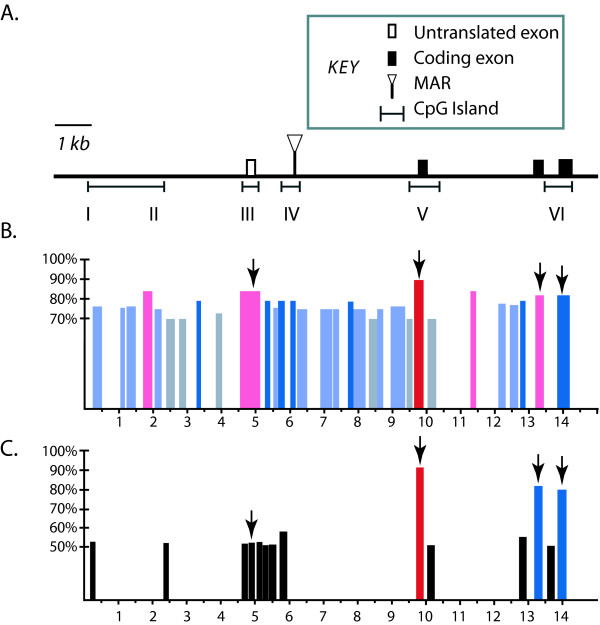
Characterization of the transcription unit for IGF2 in Monodelphis domestica. A) Genomic map of the M. domestica IGF2 gene. The scale bar is indicated and the key to the annotation, which includes coding exons, the 5' noncoding exon, the MAR predicted by MAR-Wiz and CpG islands predicted by CpG Plot, is shown below. B) & C) Evolutionary conserved segments within the M. domestica IGF2 locus. VISTA pairwise comparisons showing conserved segments between M. domestica and B) Macropus eugenii, C) Homo sapiens. Percent homology is indicated on the Y-axis and the position and size of regions of high homology are indicated on the X-axis in kilobases according to the reference sequence (M. domestica). Arrows denote the four exons in M. domestica. Black bars indicate >50% identity, light blue bars indicate >75% identity, dark blue bars indicate >80% identity, pink bars indicate >85% identity, and red bars indicate >90% identity.